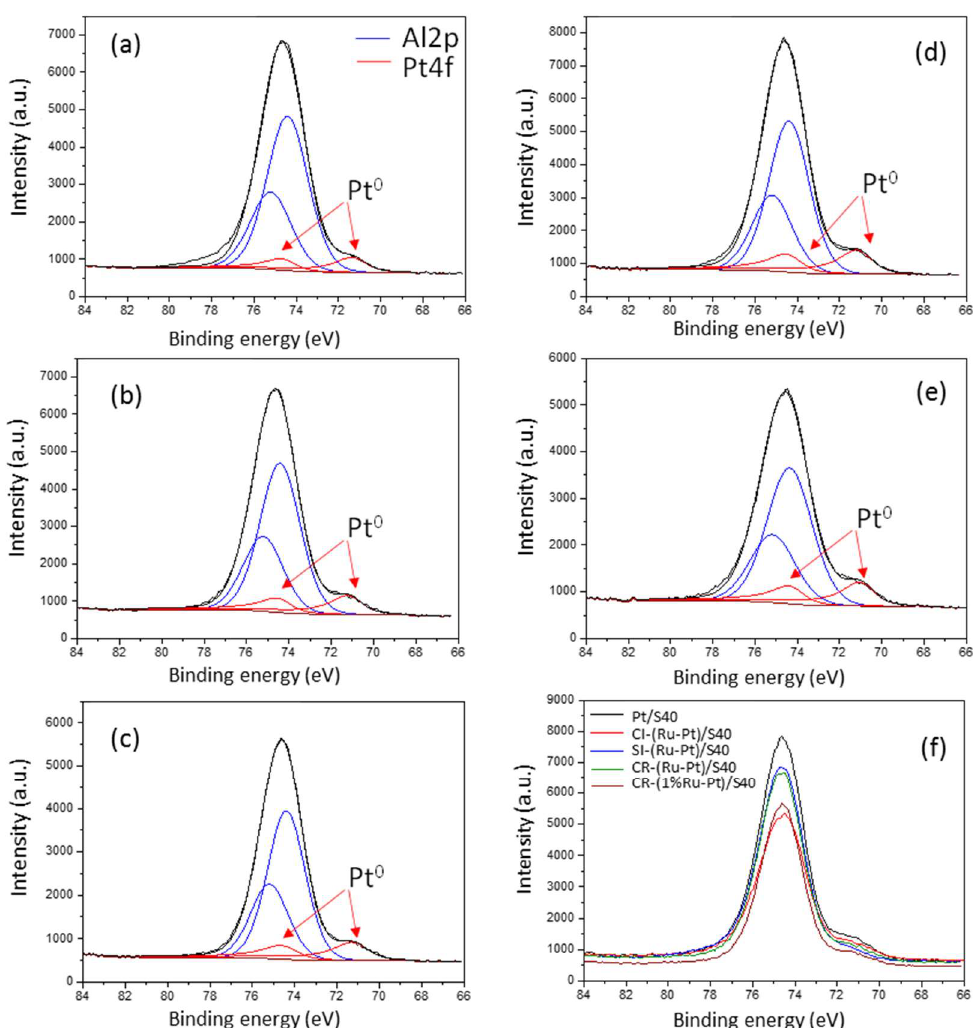
Figure 3. Curve fit of XPS data for Pt 4f region: ( a ) SI–(Ru–Pt)/S40, ( b ) CR–(Ru–Pt)/S40, ( c ) CR–(1%Ru–Pt)/S40, ( d ) Pt/S40, ( e ) CI–(Ru–Pt)/S40, ( f ) superposition of the Al 2p and Pt 4f bands for all samples.